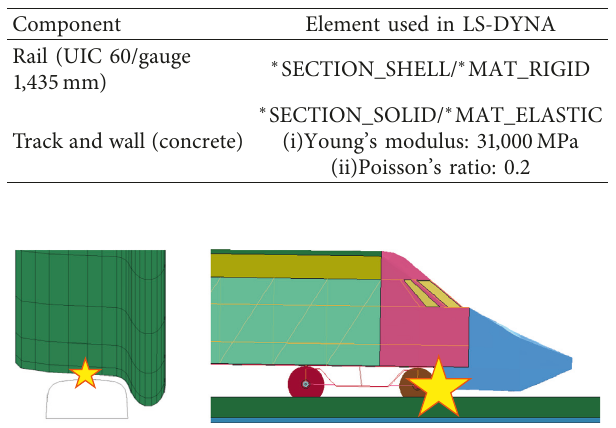
Figure 3: Contact conditions between the train and track. Table 2: Contact conditions between the train and track. Contact condition